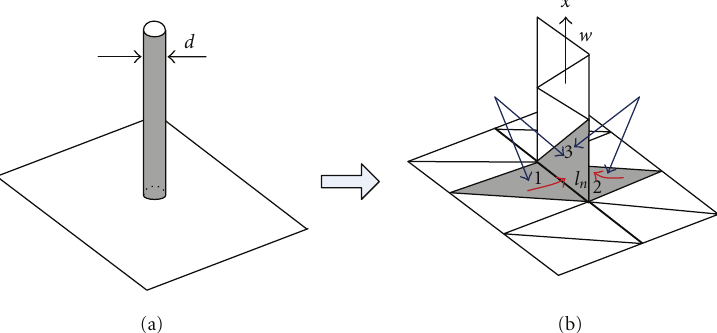
Figure 2: Dipole model in the excitation source of antenna. (a) Wire-surface junction. (b) Surface-surface junction and its equivalent electric dipole model.